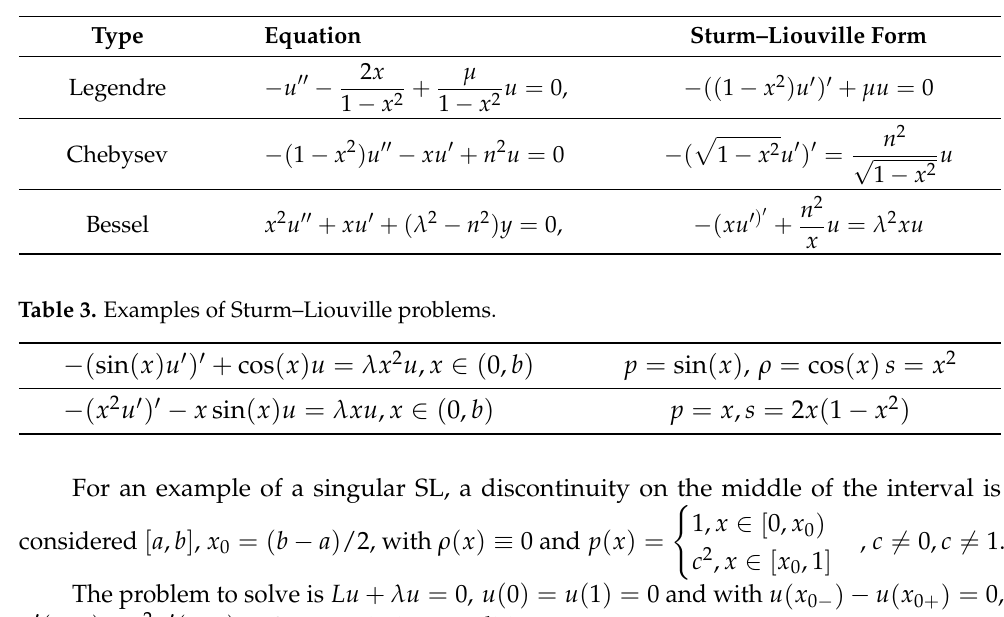
Table 2. Examples of differential equations and their SL form.